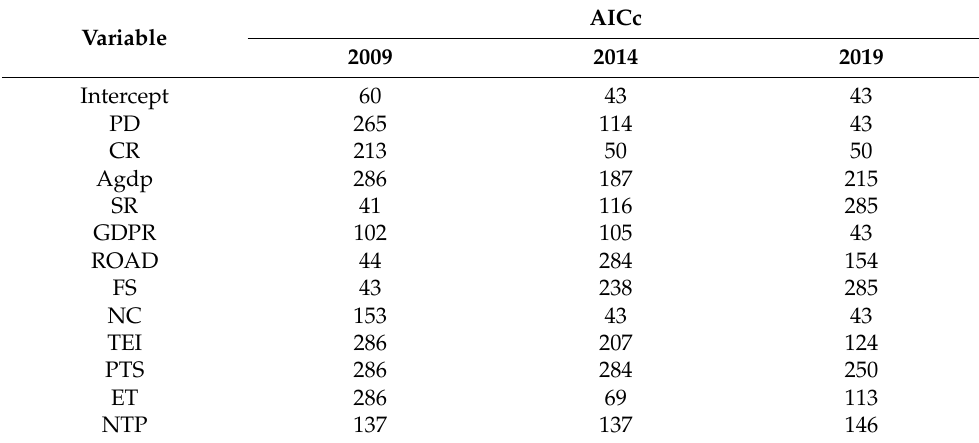
Table 4. AICc value of each variable.